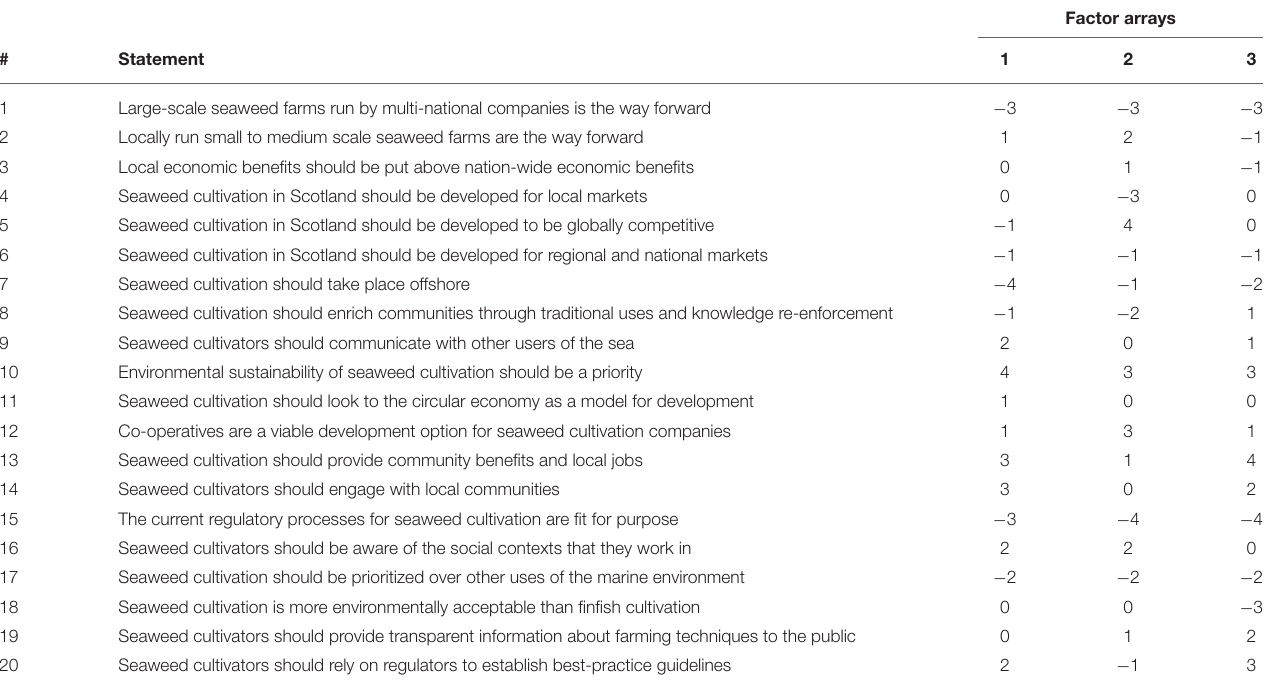
TABLE 5 | Factor Q sort values for each statement.